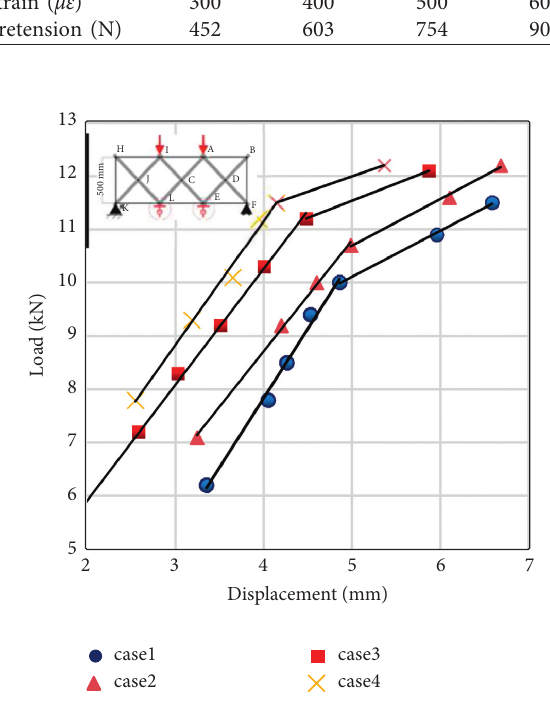
Figure 9: Load-displacement curve of the cable-strengthened